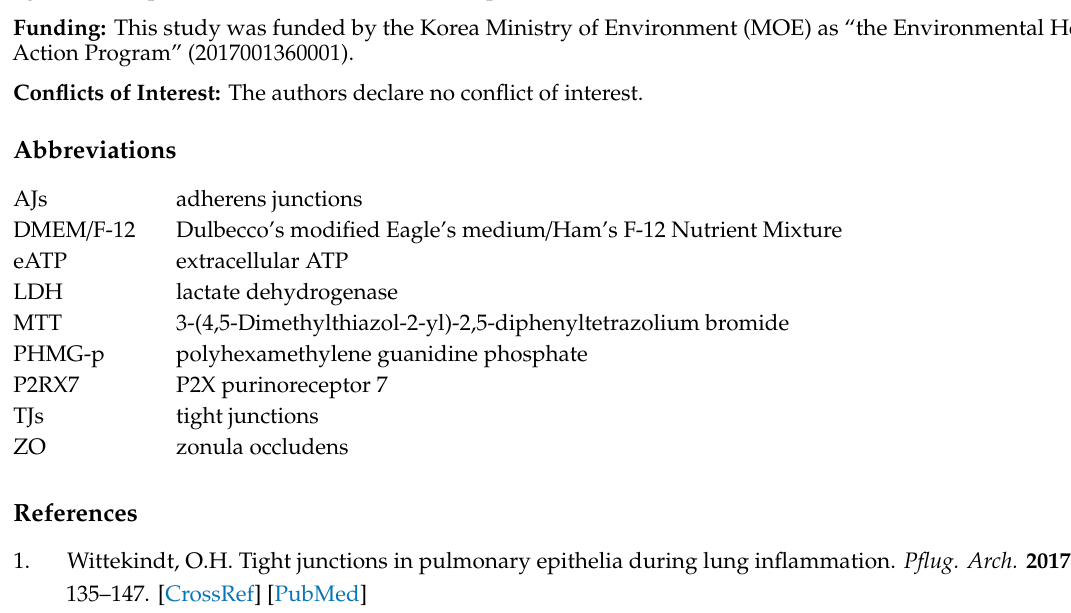
Figure S1: PHMG-p decreases cell viability by calapin-1 activation; Figure S2: PHMG-p induces ATP-independent activation of